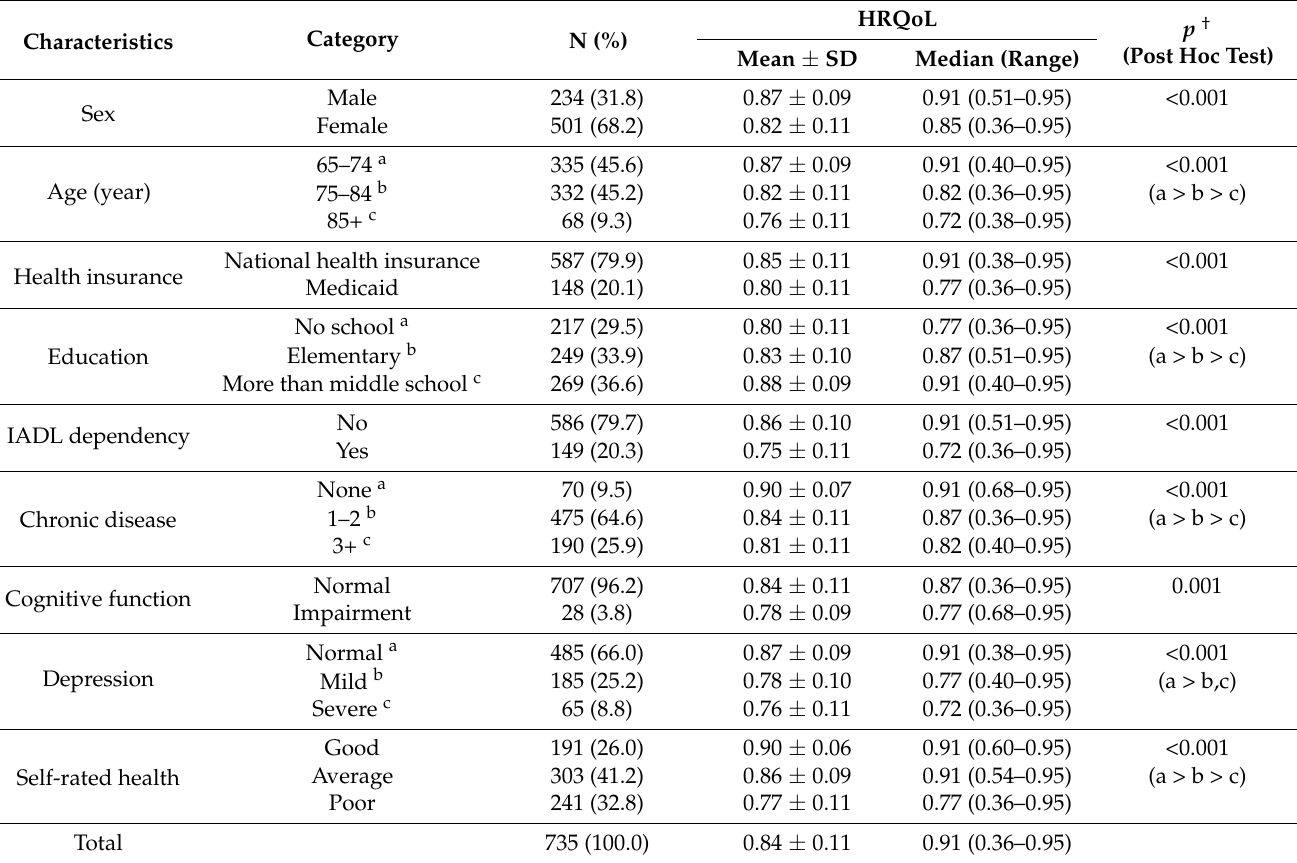
Table 1. Characteristics and health-related quality of life of participants; N =